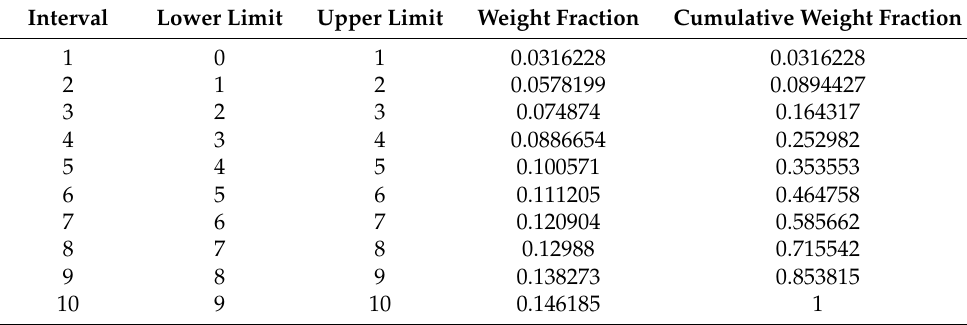
Table 4. PSD inside the air reactor calculated with ASPEN Plus